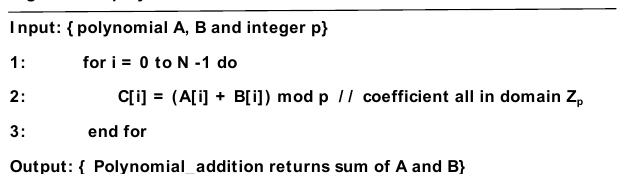
Algorithm 1 polynomial modular addition